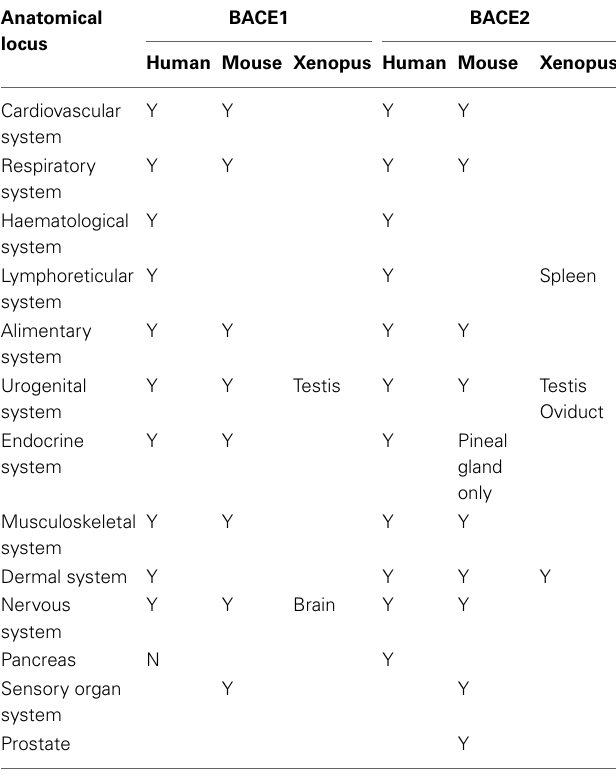
Table 3 | Results of Ka/Ks analysis for subsections of BACE1 and BACE2 cDNA sequences.